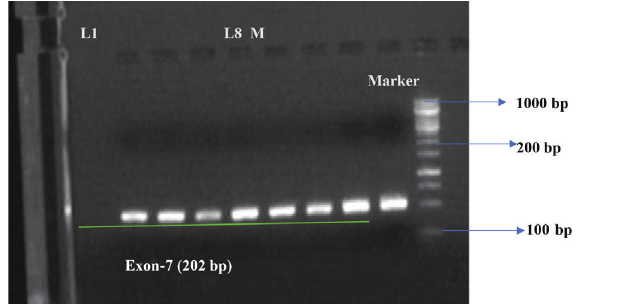
Figure 7. Agarose gel electrophoresis of PCR results of Exon-7 (TP53) Agarose gel electrophoresis (1.5%) results of exon 7 of the human TP53 gene. L1-L8: amplified bands (202bp) of exon 7, L9/M: DNA-marker (1000bp).